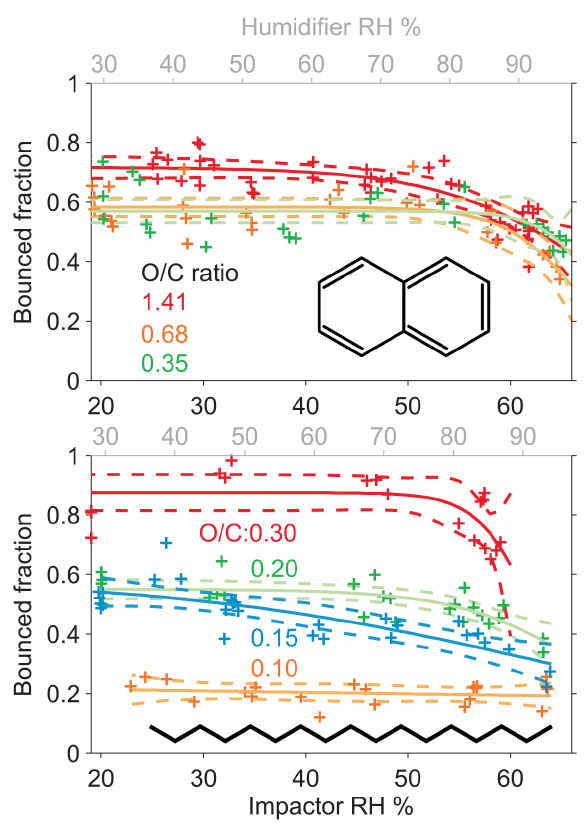
Fig. 7. Bounce behavior of SOA from photo-oxidation of naphtha- lene (upper panel) and n -heptadecane (lower panel).